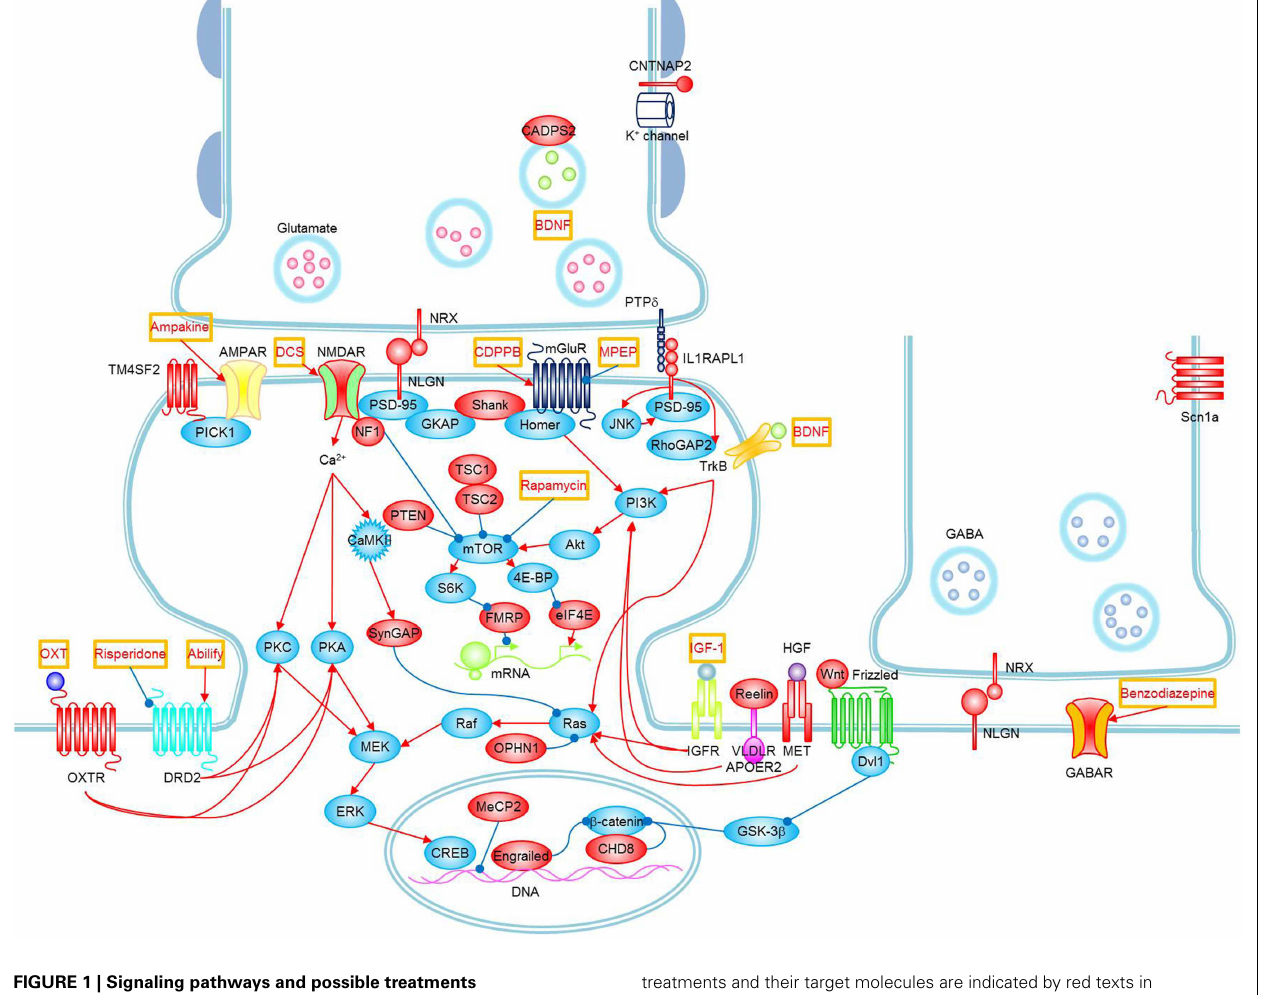
treatments and their target molecules are indicated by red texts in orange boxes. SynGAP1, which directly interacts with PSD-95, could not be placed next to PSD-95 for simplicity. Figure as originally published inWon et al.